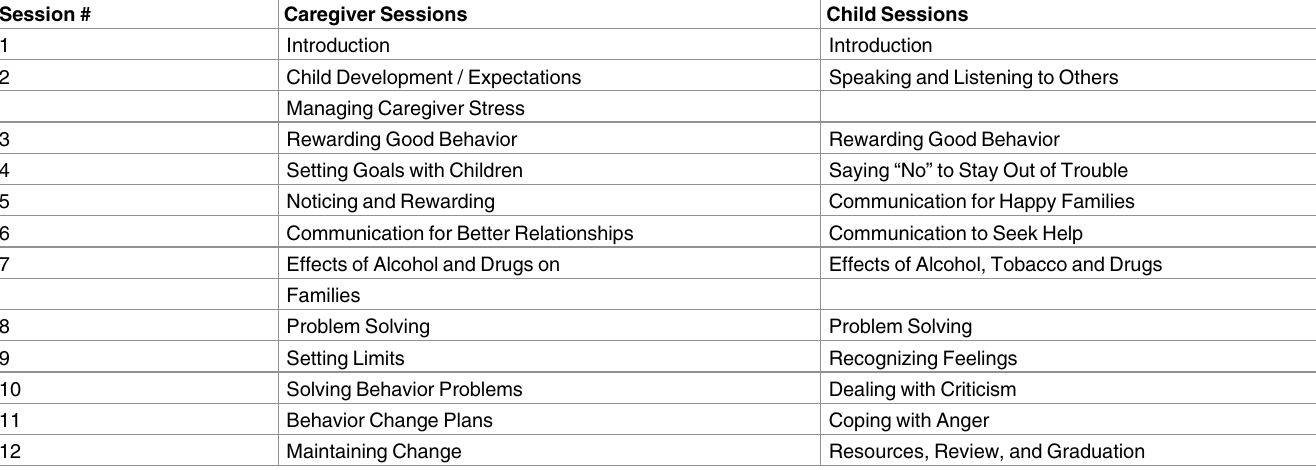
Table 1. Intervention Outline: Happy